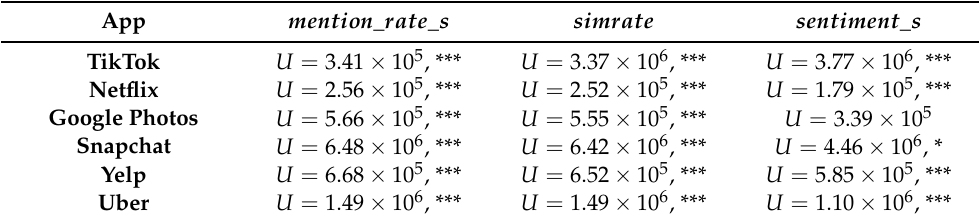
Table 9. Mann–Whitney U test results for the features in high/low